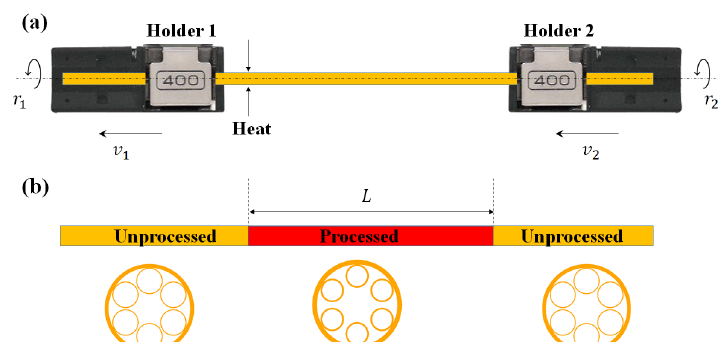
Figure 3. ( a ) Schematic diagram of the HC-ARF processing, r 1 = r 2 = 50 rpm, v 1 = v 2 = 0.5 µ m/ms; heating is realized with a CO 2 laser. ( b ) During the process, the HC-ARF undergoes structural deformation, yielding a thicker wall. L is the length of the processed fiber.